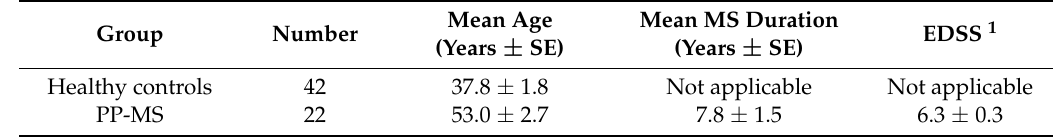
Table 1. Demographics of female primary progressive multiple sclerosis (PP-MS) patients and